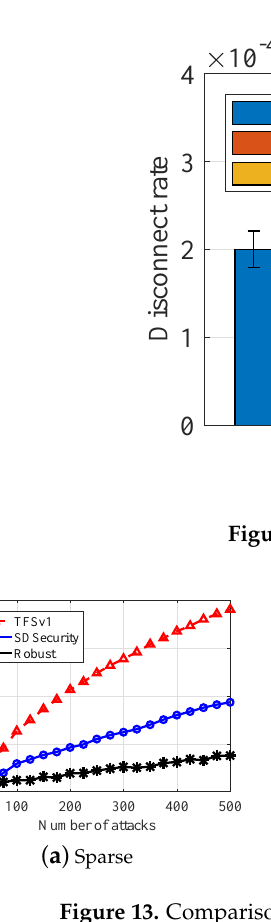
Figure 13. Comparison under replay attack. ( a ) sparse; ( b ) moderate; ( c )